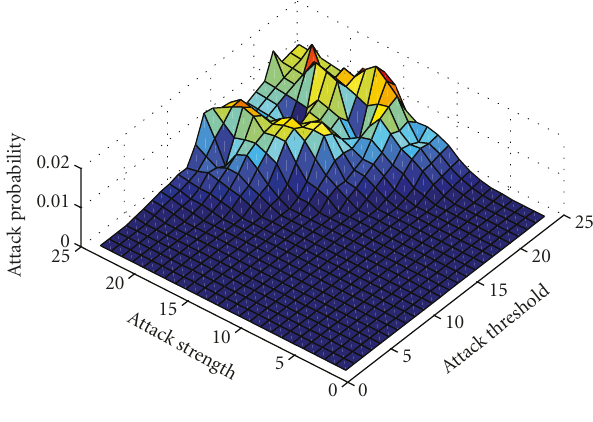
Figure 15: Damage in region.